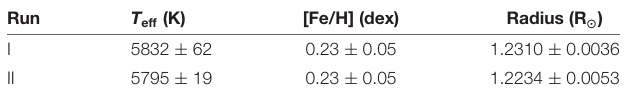
TABLE 2 | Spectroscopic and interferometric constraints.